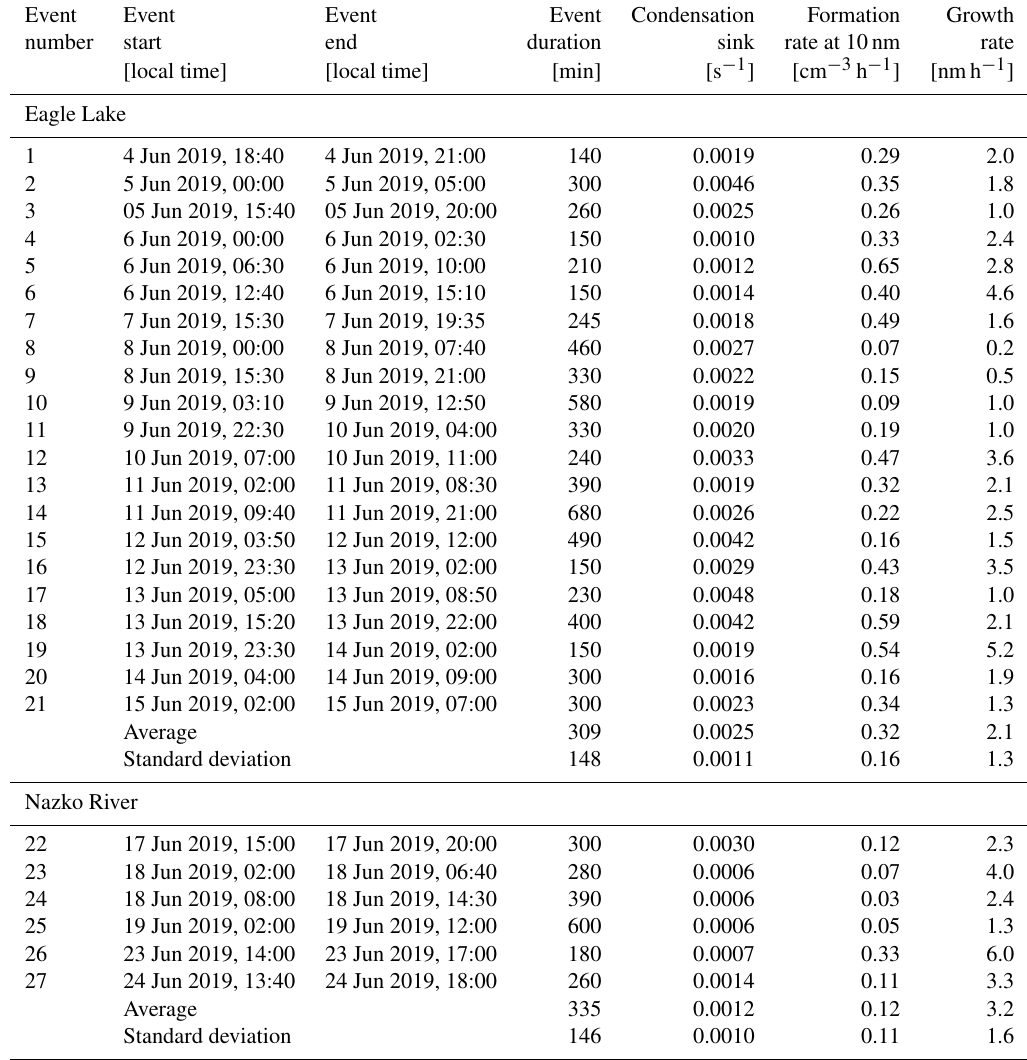
Table 1. New particle formation events at the Eagle Lake and Nazko River sites: timing, condensation sink at the beginning of the event, formation rate at 10nm, and growth